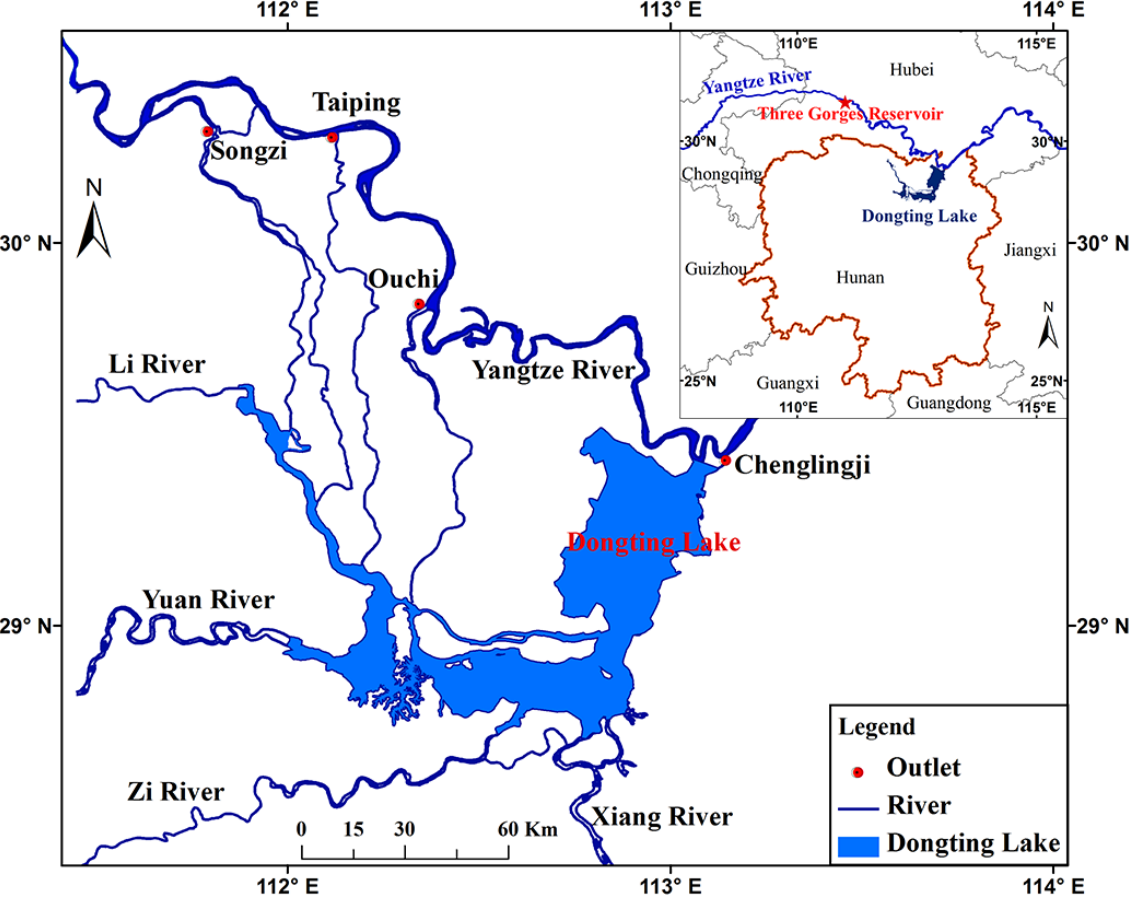
Figure 1. Geographical location and hydrological connectivity of the Dongting Lake. The red five-pointed star in the inset map indicates that the Dongting Lake is downstream of the Three Gorges